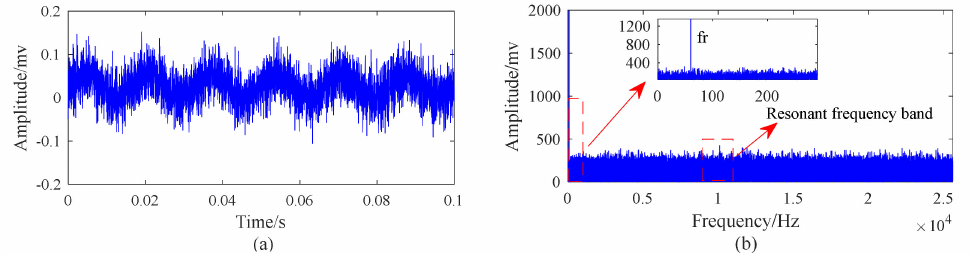
Figure 8. The simulation signal of bearing with outer race fault: ( a ) waveform; ( b ) spectrum.